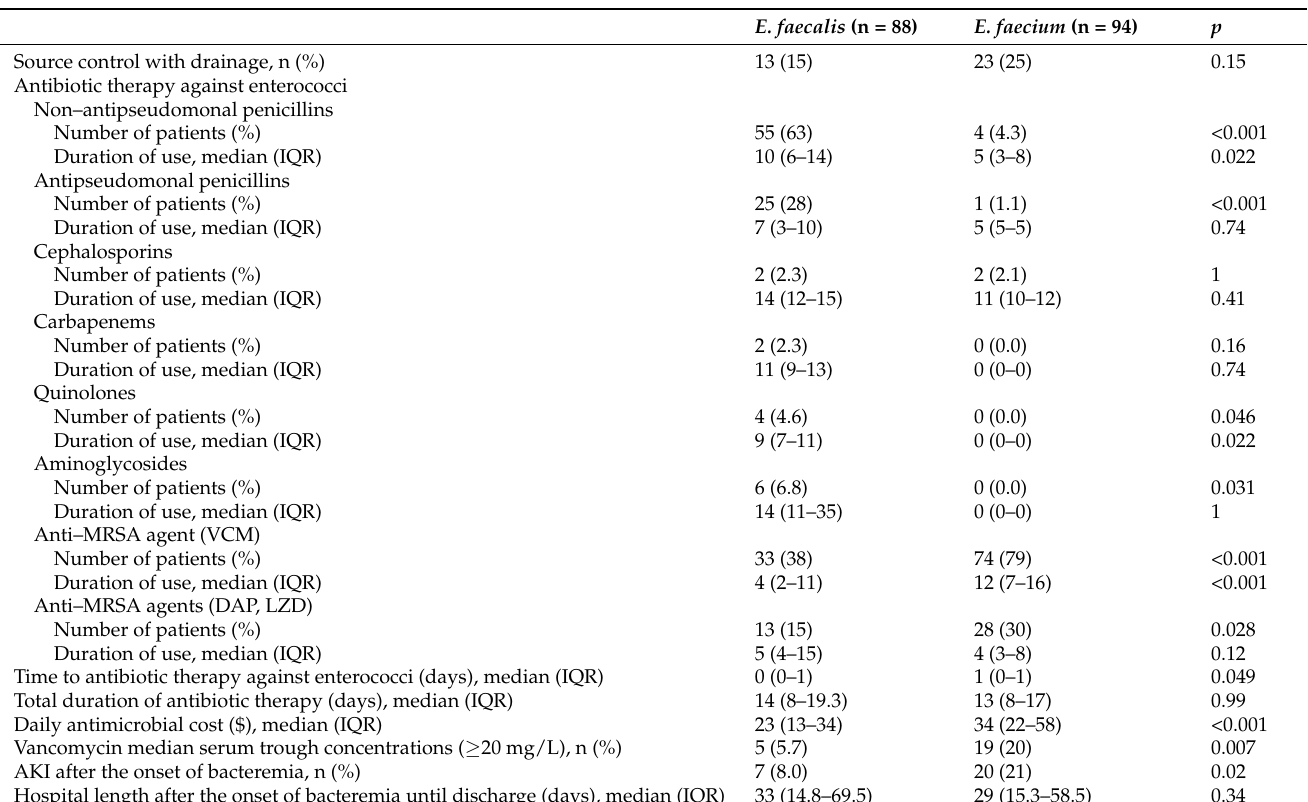
Table 3. Clinical treatments and outcomes of patients with enterococcal